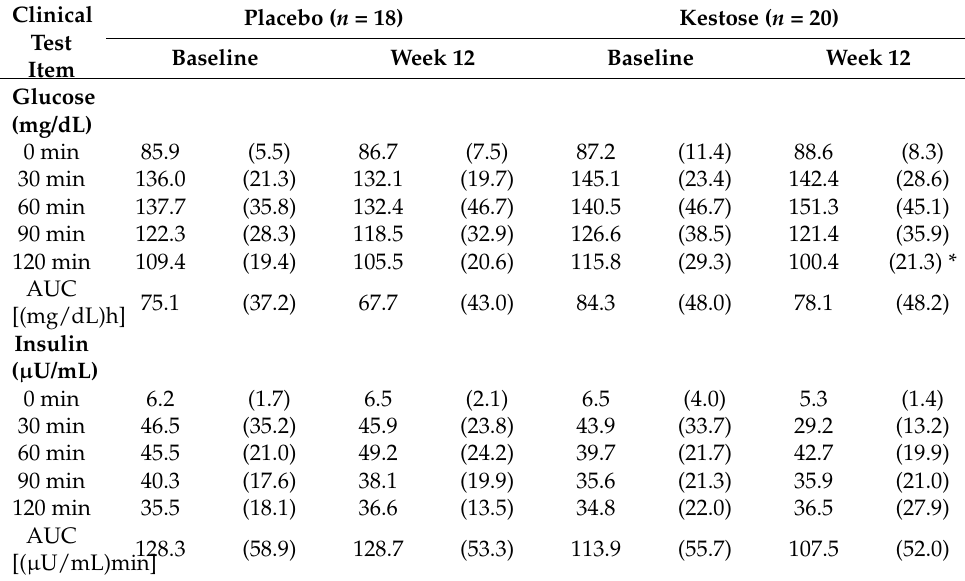
Table 2. Oral glucose tolerance tests at baseline and Week 12.